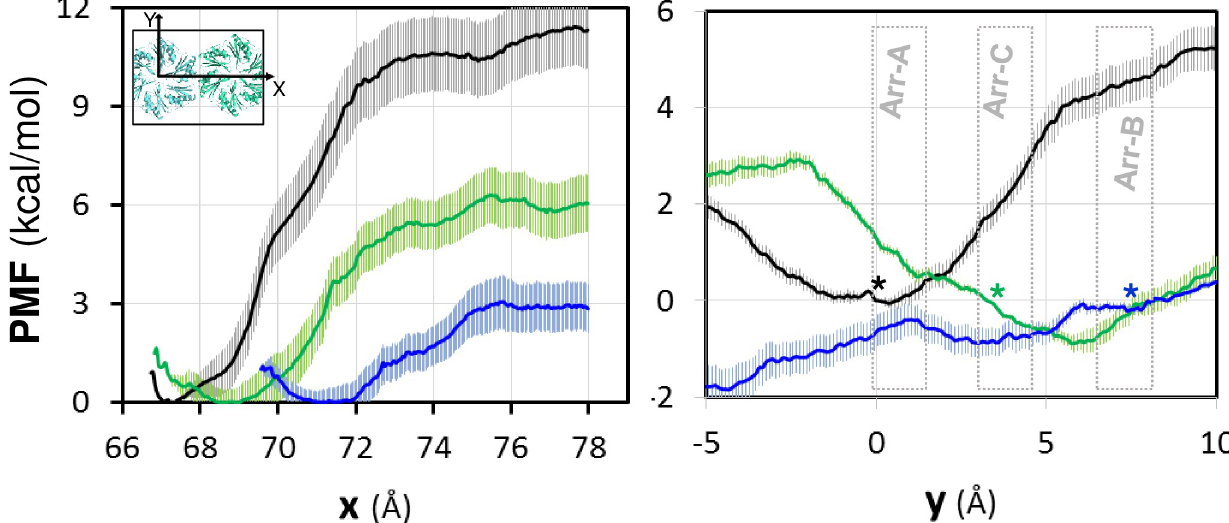
Fig 4. Potential of mean force (PMF) between two BMC-H hexamers. In the left panel, the PMF was calculated using umbrella sampling all-atom MD simulations after separating progressively the two hexamers along the x-axis defined by the two center of masses (COM) of the hexamers in the starting X- ray structure (inset). The origin of energy is taken at the minimum of the PMF so that the value of the energy at the largest distance provides an estimation of binding energies. For the right panel, the hexamers were gradually displaced along the orthogonal y-axis and the PMF was calculated using restraints to prevent bending, tilting and z-rotation. Data for PduA Sent (3NGK) is plotted in black, in blue for CcmK1 6803 (3BN4) and green for CcmK4 7942 (4OX6), including error bars estimated by bootstrapping. The approximate location of the different assembly modes is indicated in the right panel. The asterisks are to indicate the approximate position of the starting crystal for each case (following the mentioned color